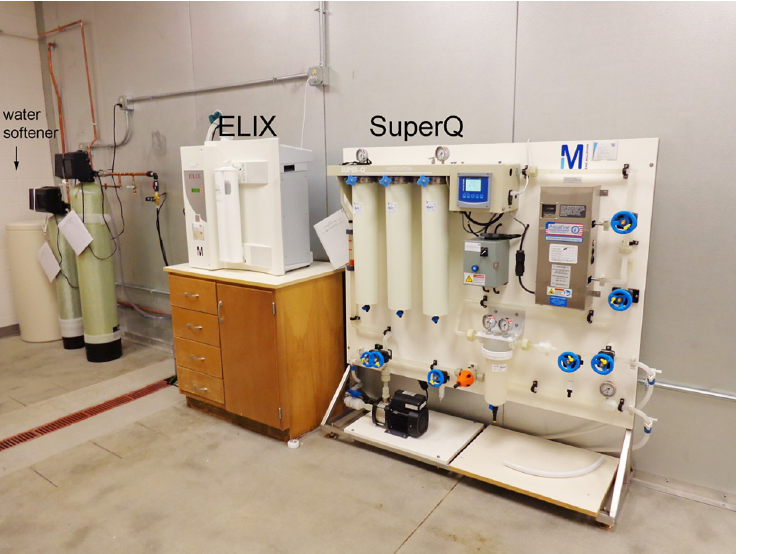
Fig 1. Components of the system that produces ultrapure